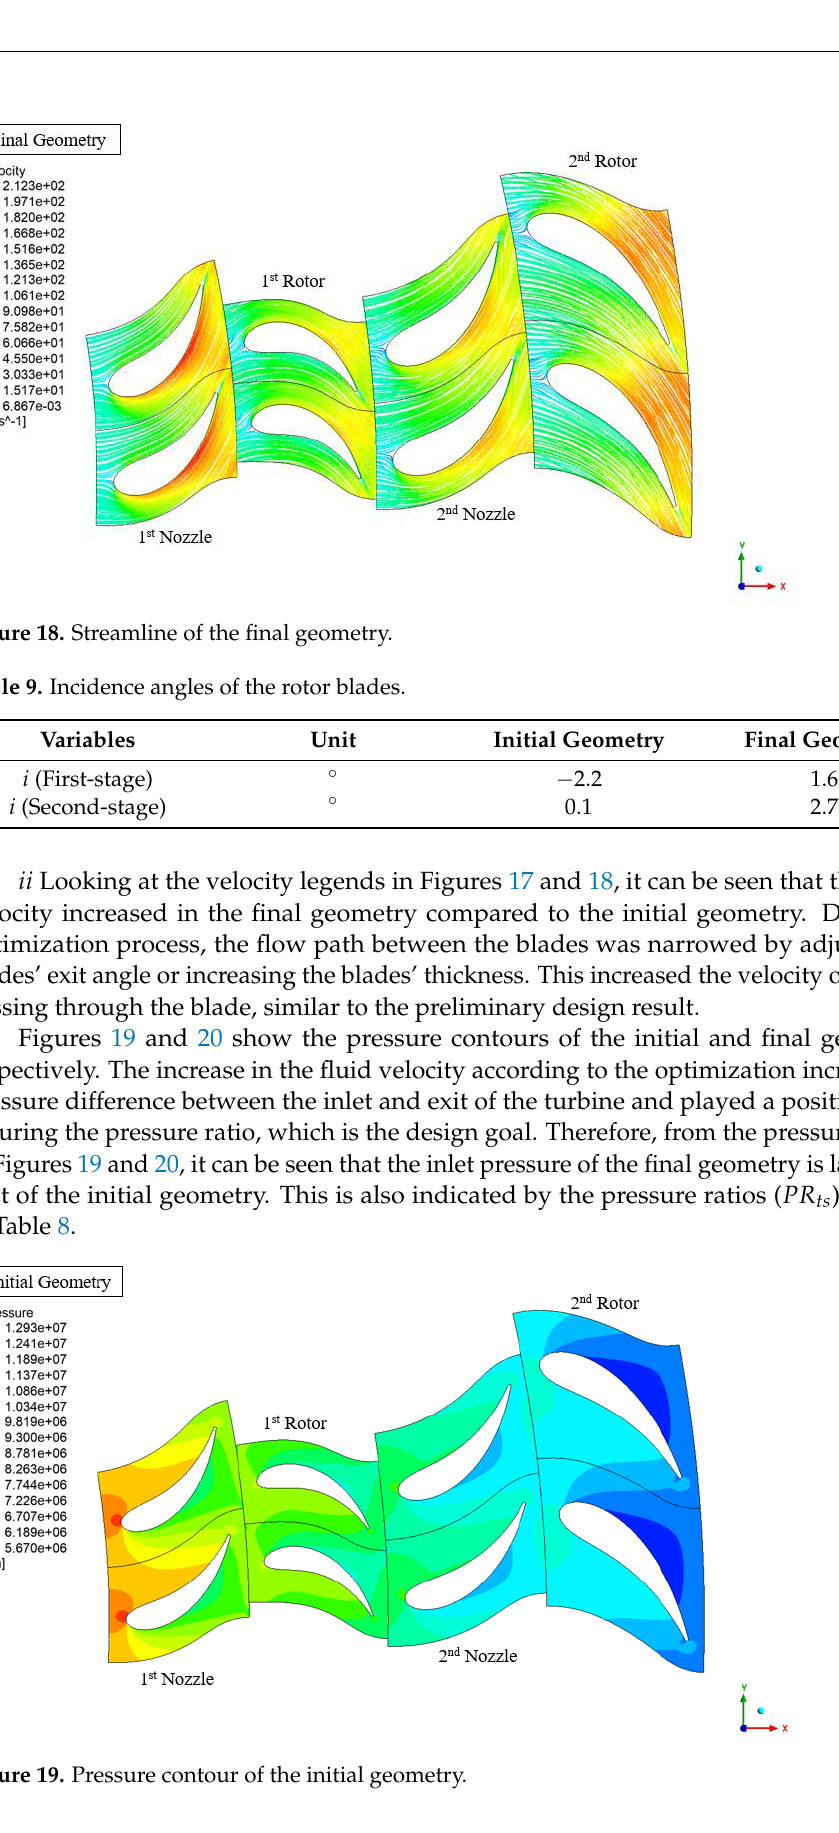
Figure 20. Pressure contour of the final geometry. Figures 21 and 22 show the Mach number contours of the initial and final geometries, respectively. Looking at the Mach number legends in Figures 21 and 22, it can be seen that the Mach number increased in the final geometry compared to the initial geometry. In particular, a high Mach number was found at the throat and exit sides of the second-rotor blade. That is, geometry optimization can ensure a high-pressure ratio and high perfor- mance but may cause an increase in the Mach number at the end of the turbine. Therefore, attention must be paid to avoid choking when optimizing the blade.